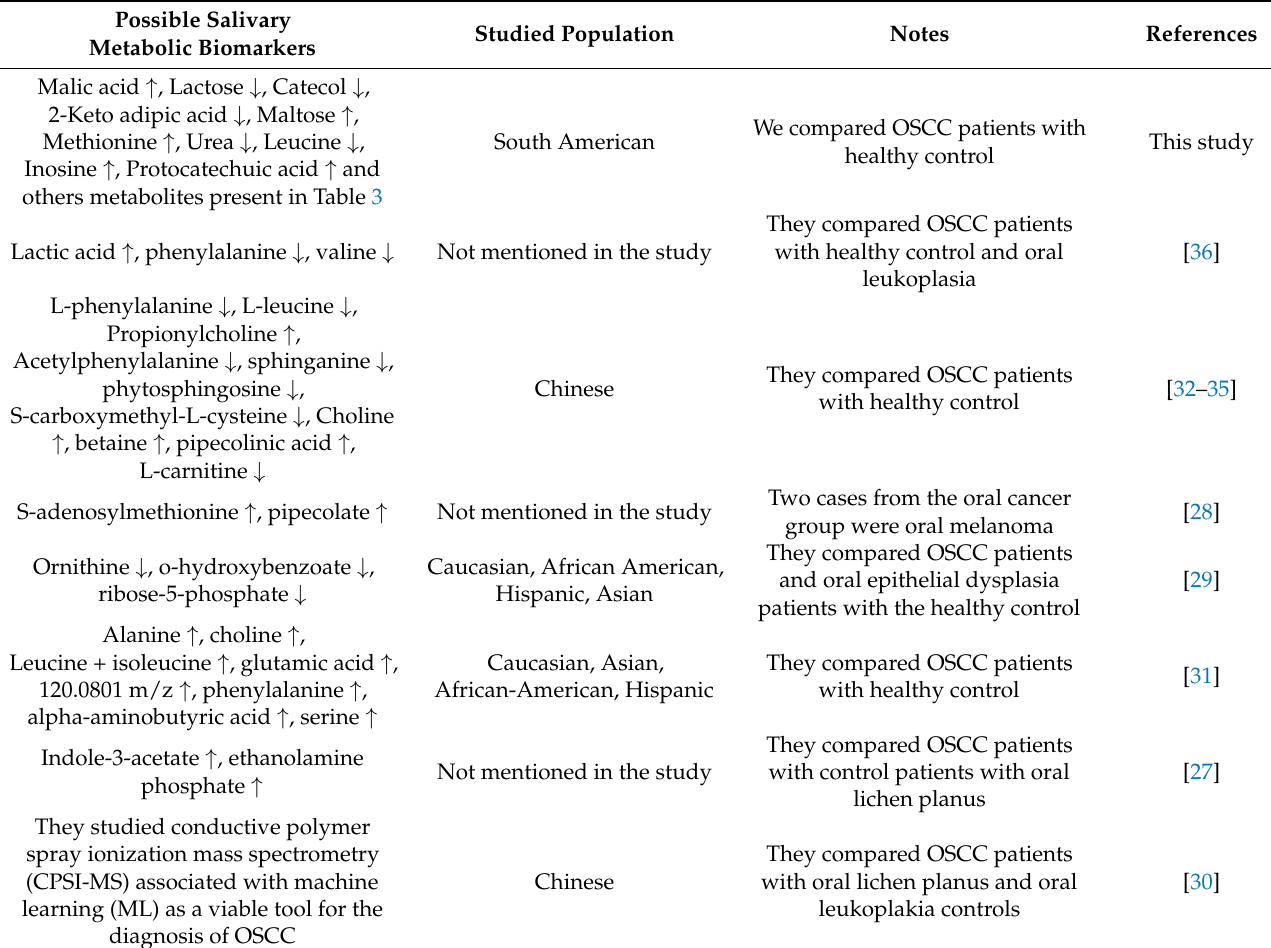
Table 6. Main salivary metabolomic studies of patients with